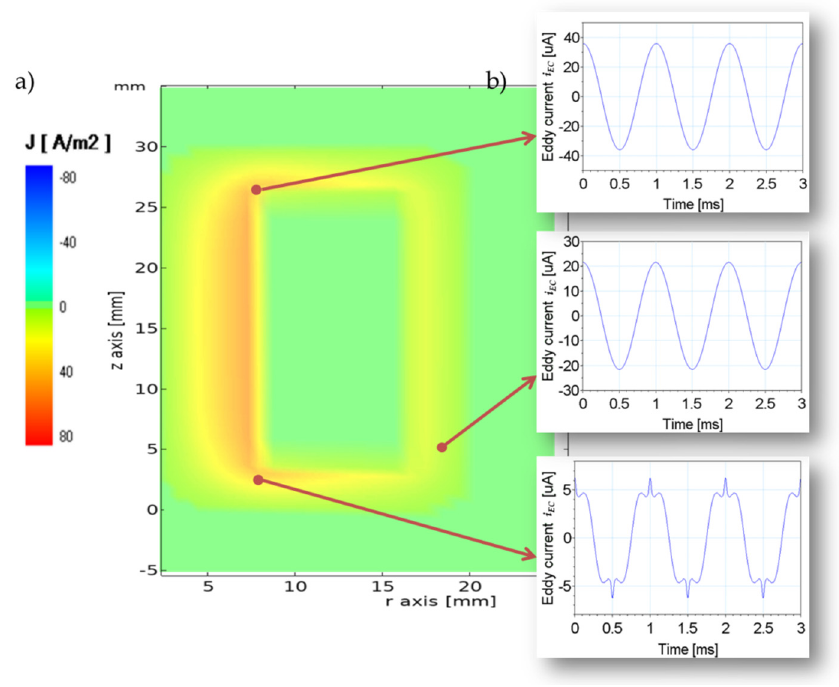
Figure 9. Distribution of the eddy current density in the ferrite core for time t =1 ms ( a ) and the waveforms of the eddy currents i EC for three selected points of ferrite core ( b ) for a frequency of 1 kHz.